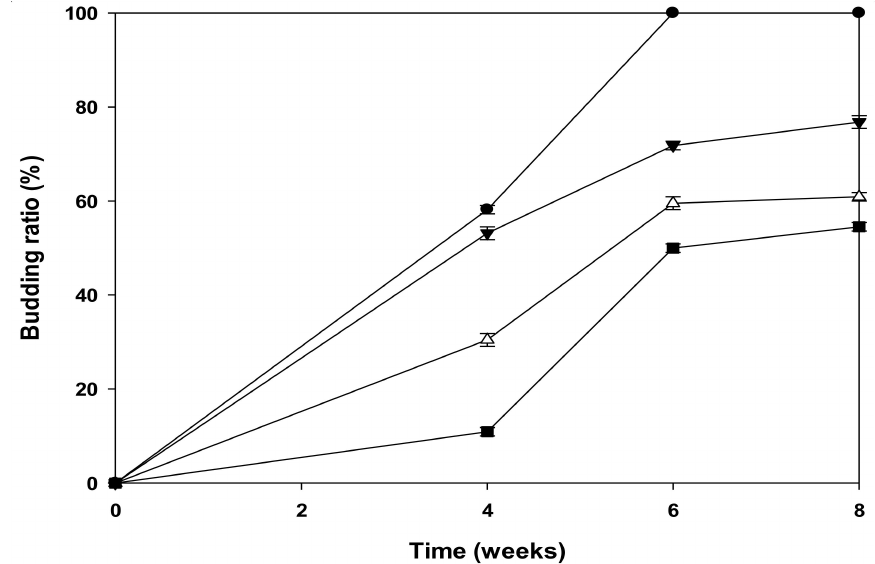
Figure 6. Budding ratios of newly developed leaves of Pachira macrocarpa plants grown in complete darkness and fed 0% ( • ), 2% ( (cid:72) ), 4% ( (cid:52) ), and 6% ( (cid:4) ) glucose. Each data point represents the mean ± SD of five independent